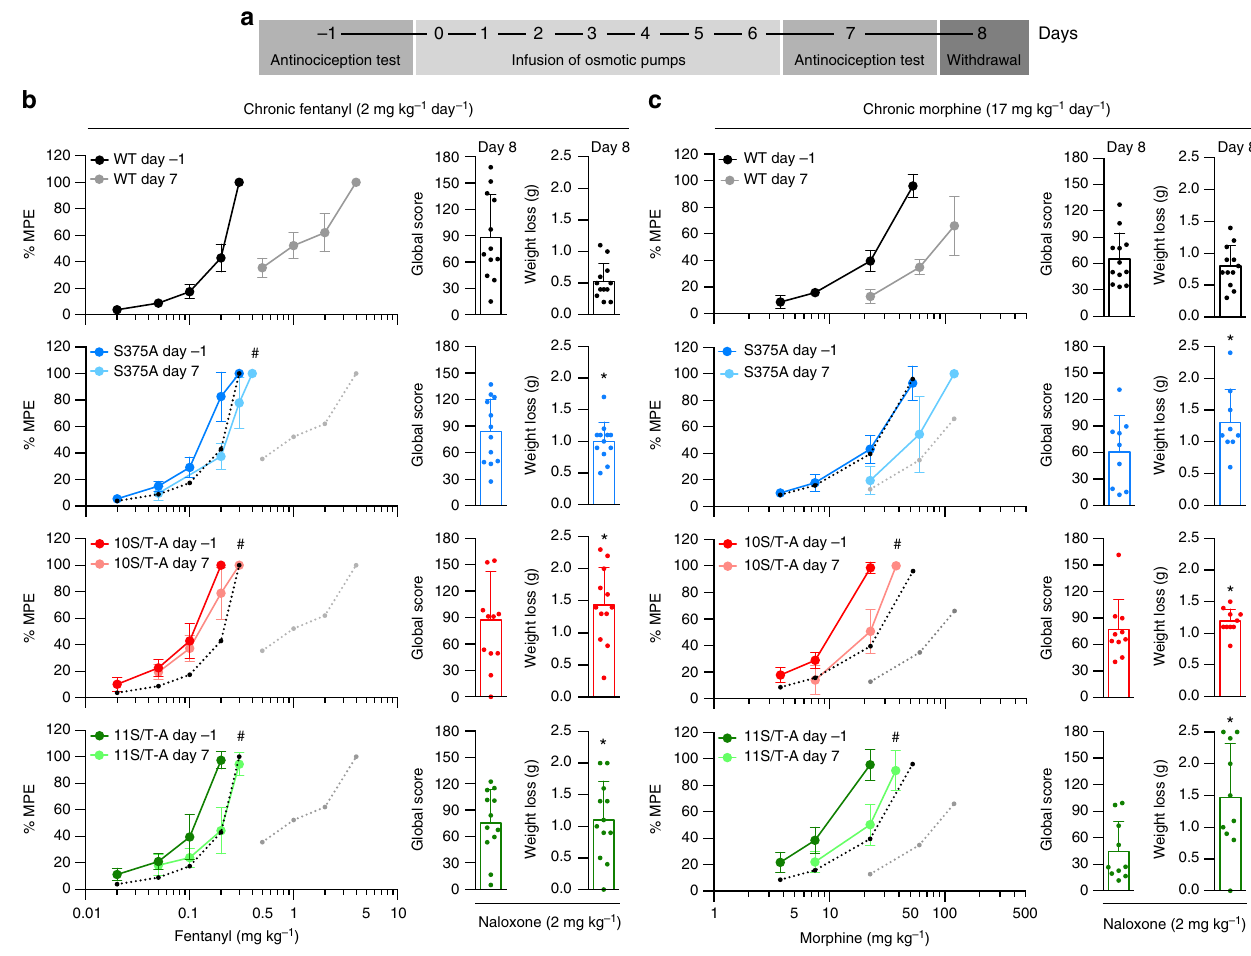
Fig. 5 Loss of tolerance and retained signs of dependence in phosphorylation-de fi cient MOP knock-in mice. a Schematic representation of the tolerance paradigm. Acute antinociceptive response measured in the mouse hot-plate test after fentanyl (15 min) or morphine (30 min) using a cumulative dosing regimen prior (day − 1) and after (day 7) to osmotic pump implantation. Withdrawal was precipitated on day 8 by naloxone injection. b , c Cumulative analgesic dose-response curves before (day − 1) and after (day 7) chronic treatment with osmotic pumps delivering b , fentanyl (2 mg kg − 1 day -1 ) or c , morphine (17 mg kg − 1 day − 1 ) measured in the hot-plate test ( n = 9 − 12). Responses are reported as percent maximum possible effect (% MPE). The cumulative analgesic dose-response curves of WT mice before and after treatment are shown as black and grey dotted lines, respectively, in the graphs of the transgenic mice for easier comparison. The bar graphs show the global withdrawal and weight loss after 2 mg kg − 1 naloxone on day 8 ( n = 9 – 12). Data are the means ± s.e.m.; # indicates statistically signi fi cant differences from comparisons of the fold shift in agonist ef fi cacy to that in WT (fentanyl: F = 72.97, P < 0.0001; morphine: F = 9.103, P = 0.0001), one-way ANOVA with Bonferroni post hoc test.; * indicates statistically signi fi (3, 44) (3, 39)